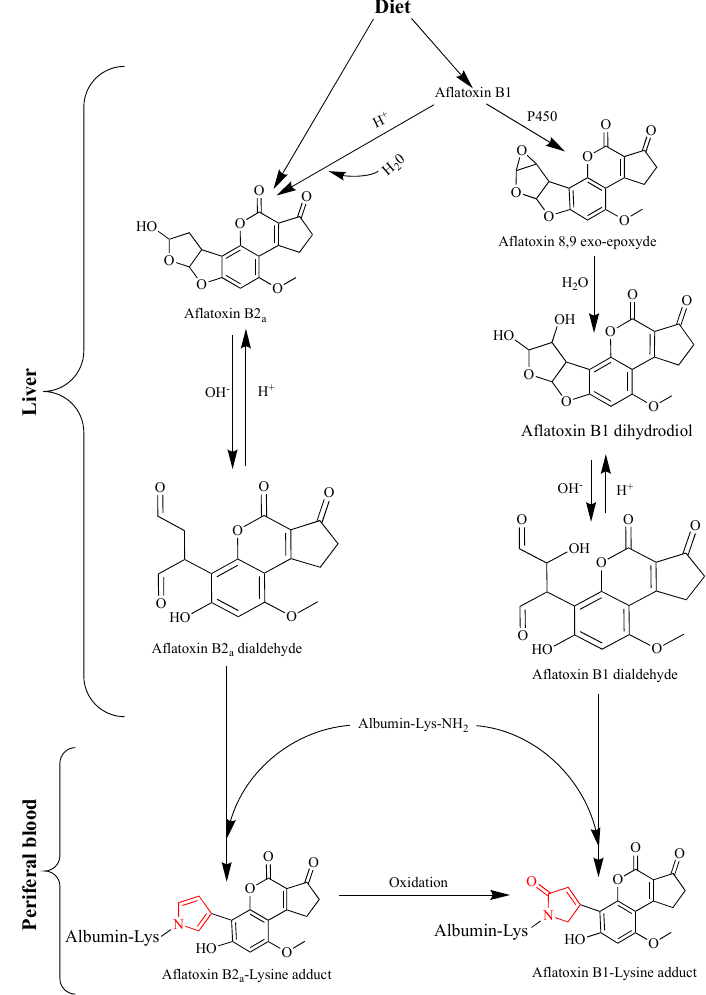
Figure 1. Comparative formation pathways of aflatoxin B1-Lys (lysine) adduct deriving exclusively from aflatoxin B1 (Right) or from aflatoxin B1 and B2 a (Left) as precursors. The pyrrole and pyrrolin-2-one rings that characterize aflatoxin B2a- and aflatoxin B1-albumin adducts are drawn in red. Adapted from [116].